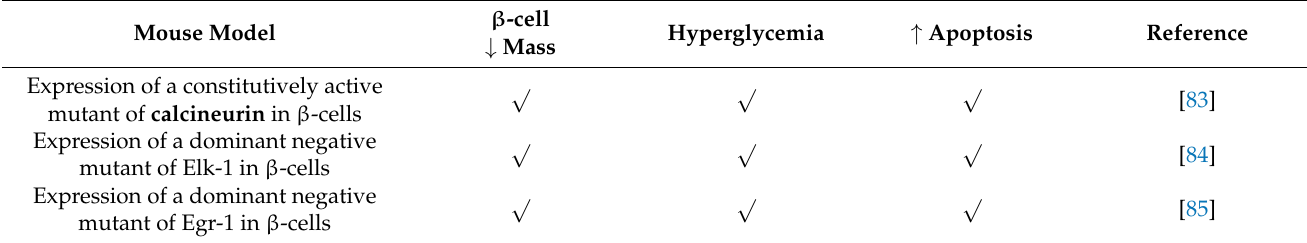
Table 1. Phenotypes of transgenic mice